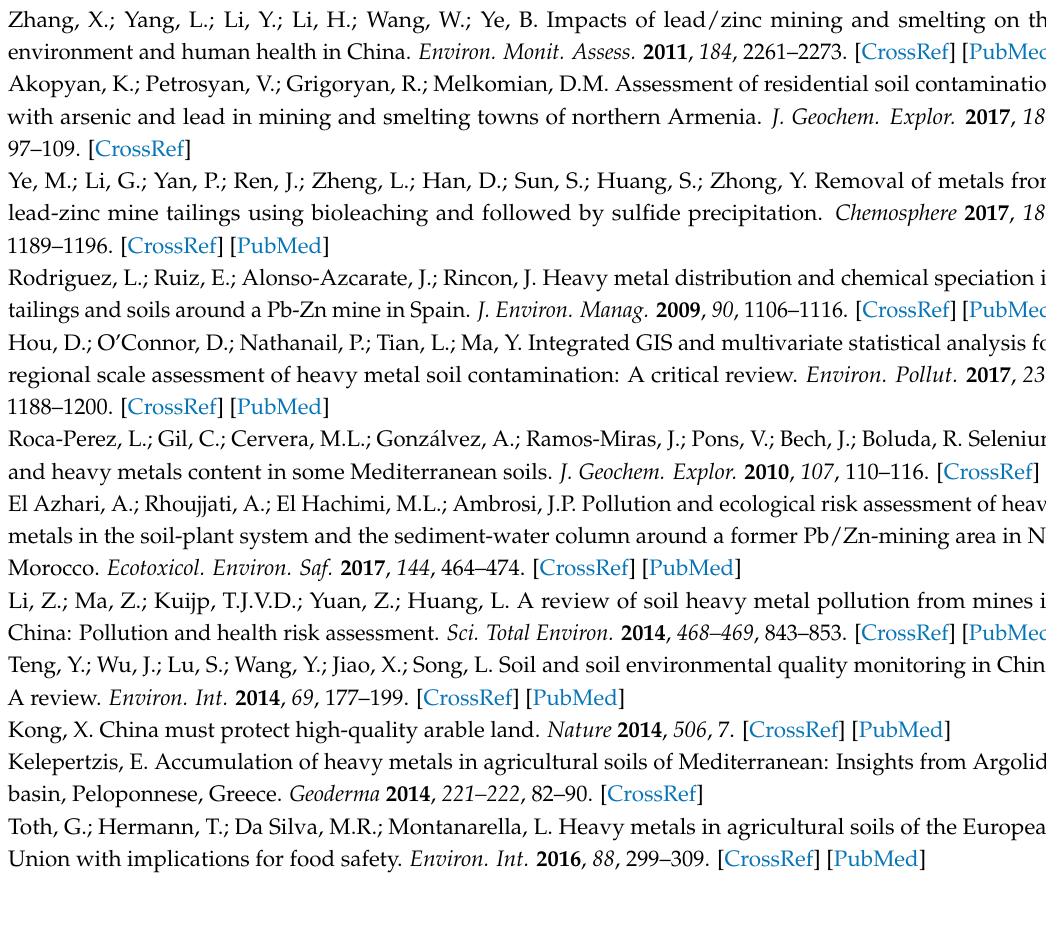
Table S1: Measured and certified concentration (mg/kg) and metal recovery of reference materials. Table S2: Pearson correlation coefficients between the toxic metals and pH. Table S3: Factor loadings of the PCA results of the toxic metals in the study